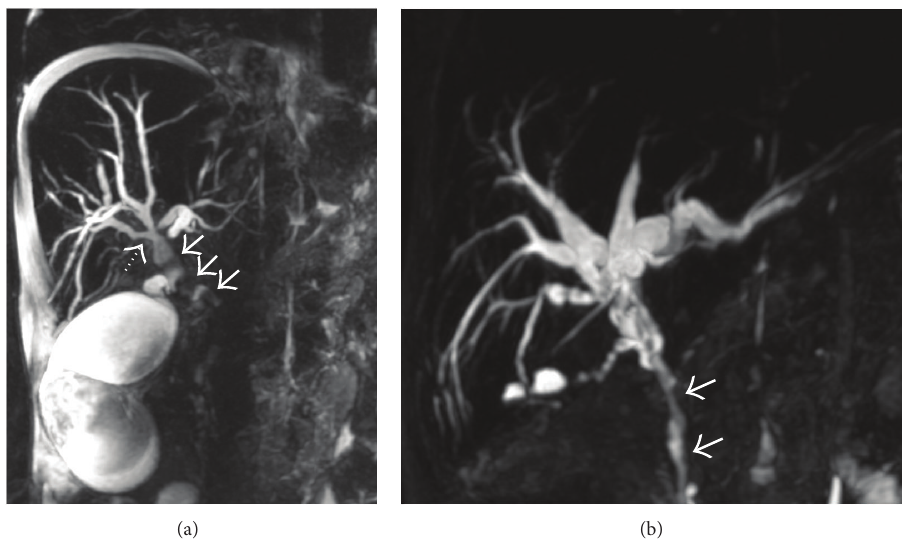
Figure 46: (a) Thick-slab 3D MRCP image of a patient with portal biliopathy demonstrating extrinsic vascular impression over CBD by the paracholedochal collaterals (solid arrows). The distal CBD is narrowed by these collaterals with resultant upstream biliary dilatation. Undulating margins of biliary system can also be seen (interrupted arrow) with a grossly distended gall bladder. (b) 3D MRCP image from another patient showing wavy contour of the mid- and distal CBD due to portal biliopathy with resultant narrowing and gross bilobar biliary dilatation.